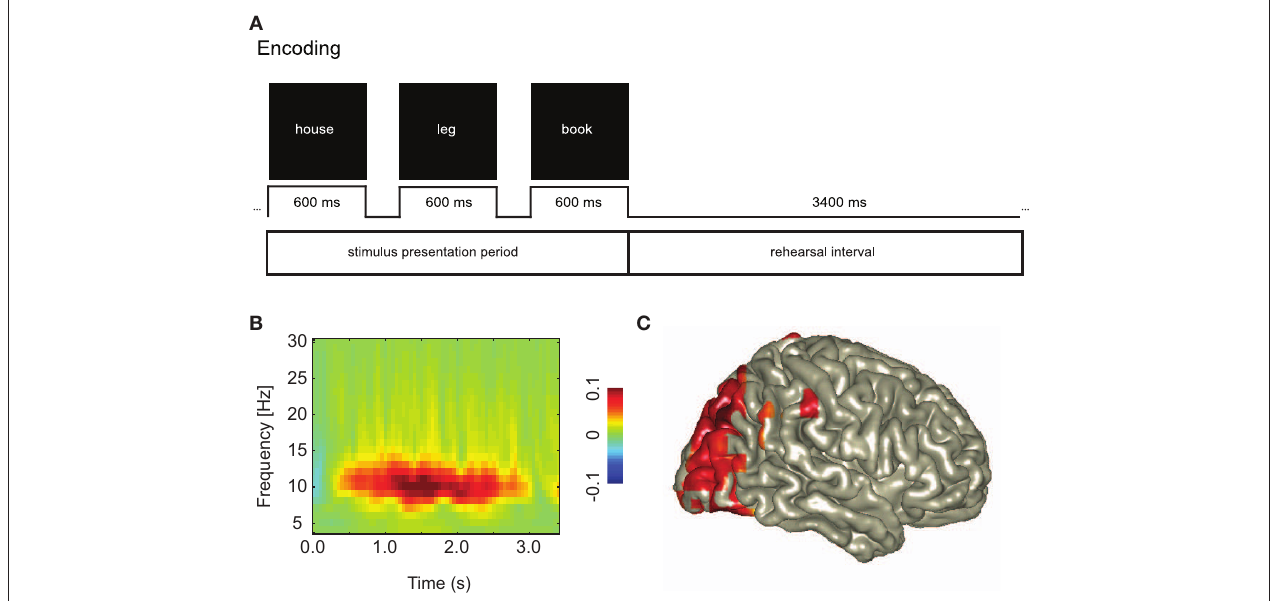
Figure 2 | An increase in posterior alpha activity predicts successful long-term memory encoding. This suggests that functional inhibition of occipital cortex is a requirement for successful memory formation. (A) Subjects were instructed to rehearse visually presented word triplets during a 3.4-s period. Later memory for the triplets was tested. This allowed for characterizing